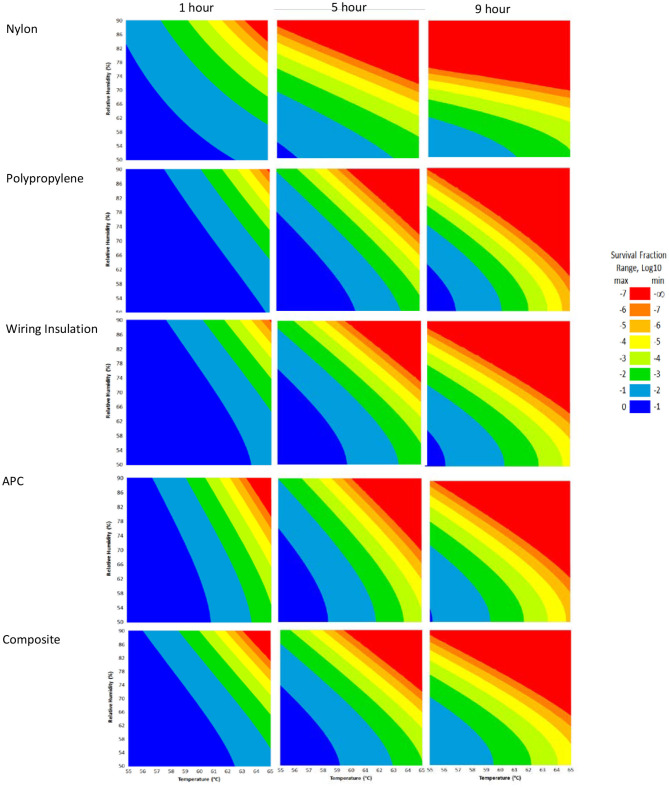
Models with a 90% statistical probability of Φ6 virus inactivation after virus was dried on to nylon, polypropylene, wiring insulation, or aircraft performance coating after incubation in hot humid air. Composite models are the accumulation of data for all 4 materials. Areas are represented as >7 log10 (red), 6–7 log10 (orange), 5–6 log10 (gold), 4–5 log10 (yellow), 3–4 log10 (green), 2–3 log10 (dark green), 1–2 log10 (blue), and <1 log10 (dark blue) virus inactivation.